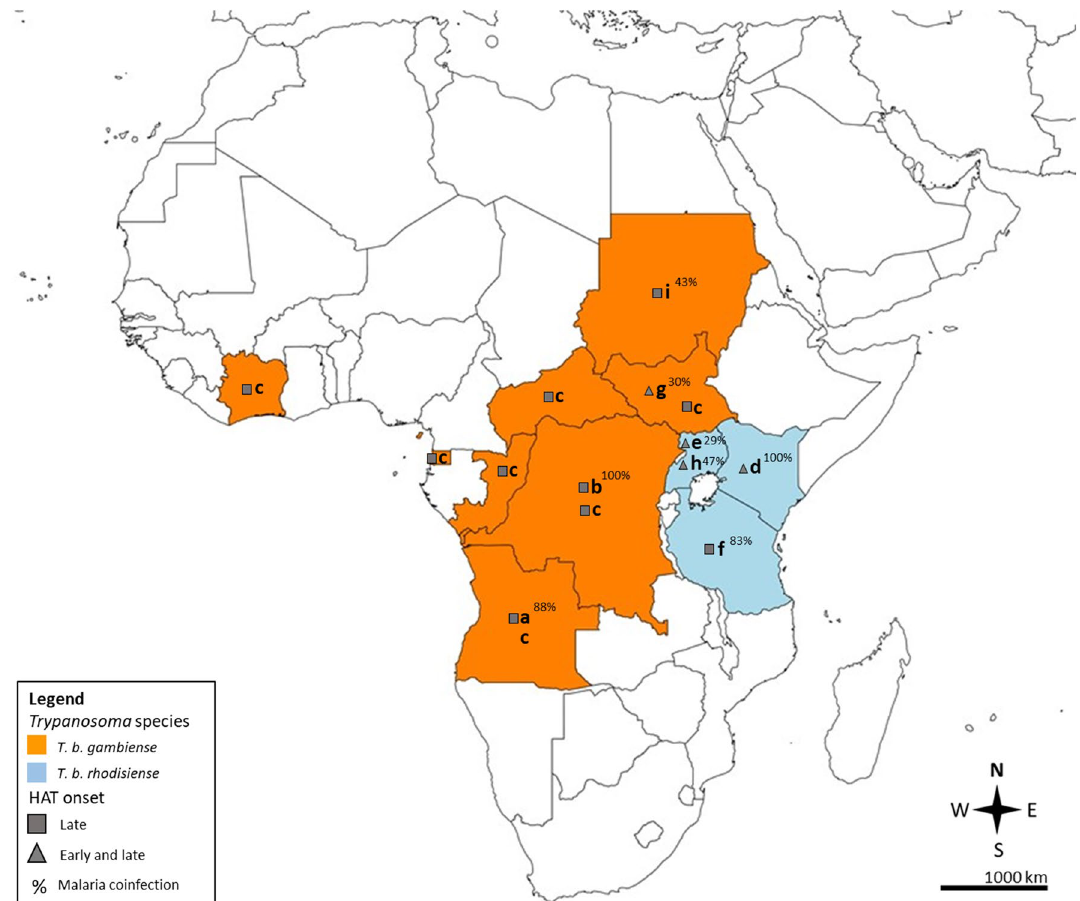
Figure 2. Epidemiology of Human African trypanosomiasis (HAT) and malaria co-infection in the African continent. HAT human African trypanosomiasis; T. b. Trypanosoma brucei ; ( a) Angola; ( b) Democratic Republic of Congo; ( c) Angola, Central African Republic, Cˆote d’Ivoire, Democratic Republic of Congo, Republic of Congo, Equatorial Guinea, and South Sudan; ( d) Kenya; ( e) Uganda; ( f) Tanzania and Uganda; ( g) South Sudan; ( h) Uganda; ( i) Sudan. Map was retrieved and modified by the authors from https:// mapch art. net/ world. html. Authors are allowed to use, edit, and modify any map created with mapchart.net for publication freely by adding the reference to